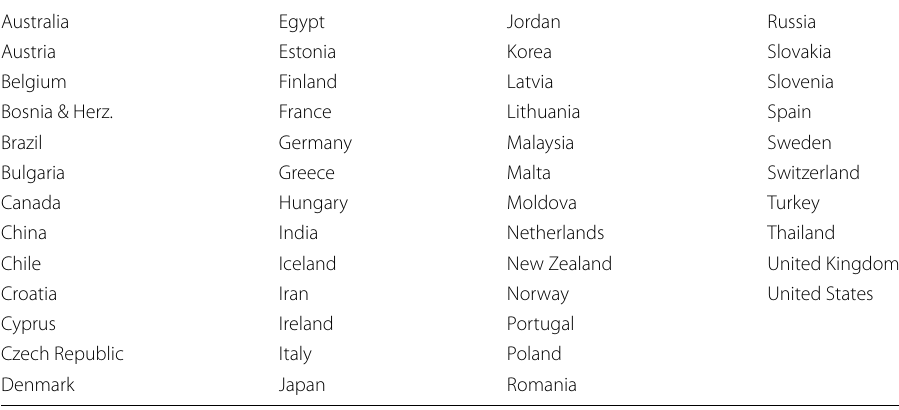
Table 10 List of countries results of top 10% income share